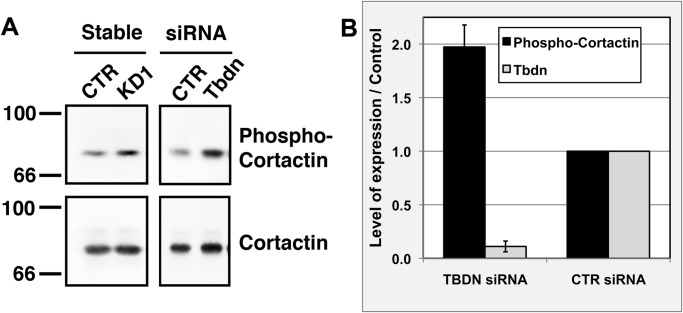
Tbdn knockdown in retinal endothelial cells leads to an increase in phospho-Cortactin (Tyr421). (A) Tbdn expression was knocked down in RF/6A retinal endothelial cells by either stable transfection of an antisense Tbdn construct (Stable KD1) or transient transfection of a Tbdn siRNA (siRNA Tbdn). Cell extracts from Tbdn knockdowns and from respective controls (Stable CTR or siRNA CTR) were analyzed for levels of phospho-Cortactin (Tyr421) versus total Cortactin by western blotting. Representative results are shown. (B) Levels of phospho-Cortactin (Tyr421) over total Cortactin and levels of Tbdn over loading control were quantified in controls (CTR siRNA) or Tbdn knockdown (Tbdn siRNA) (P<0.018). Data is expressed as mean±s.e.m. of 4 experiments.